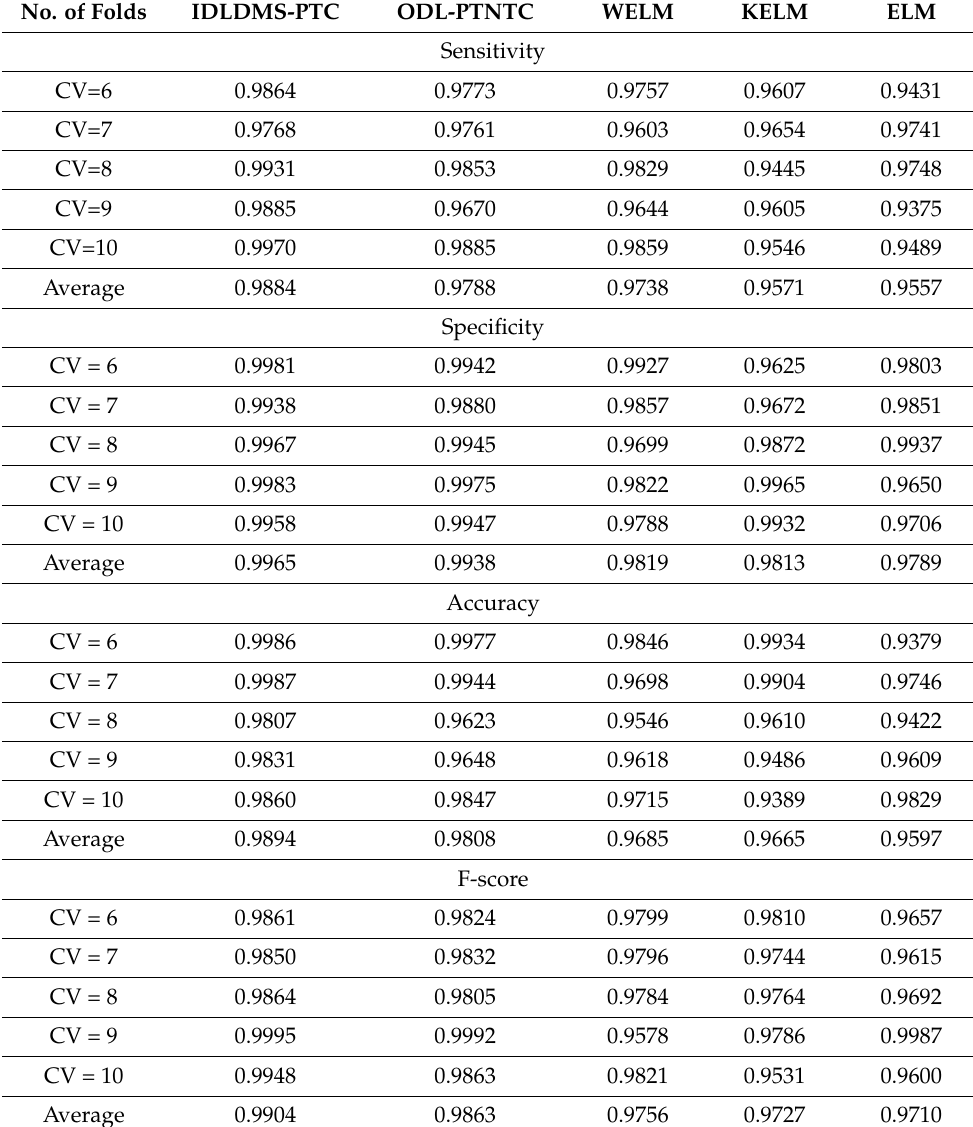
Table 2. Result analysis of IDLDMS-PTC technique under different sizes of CV with existing ap-